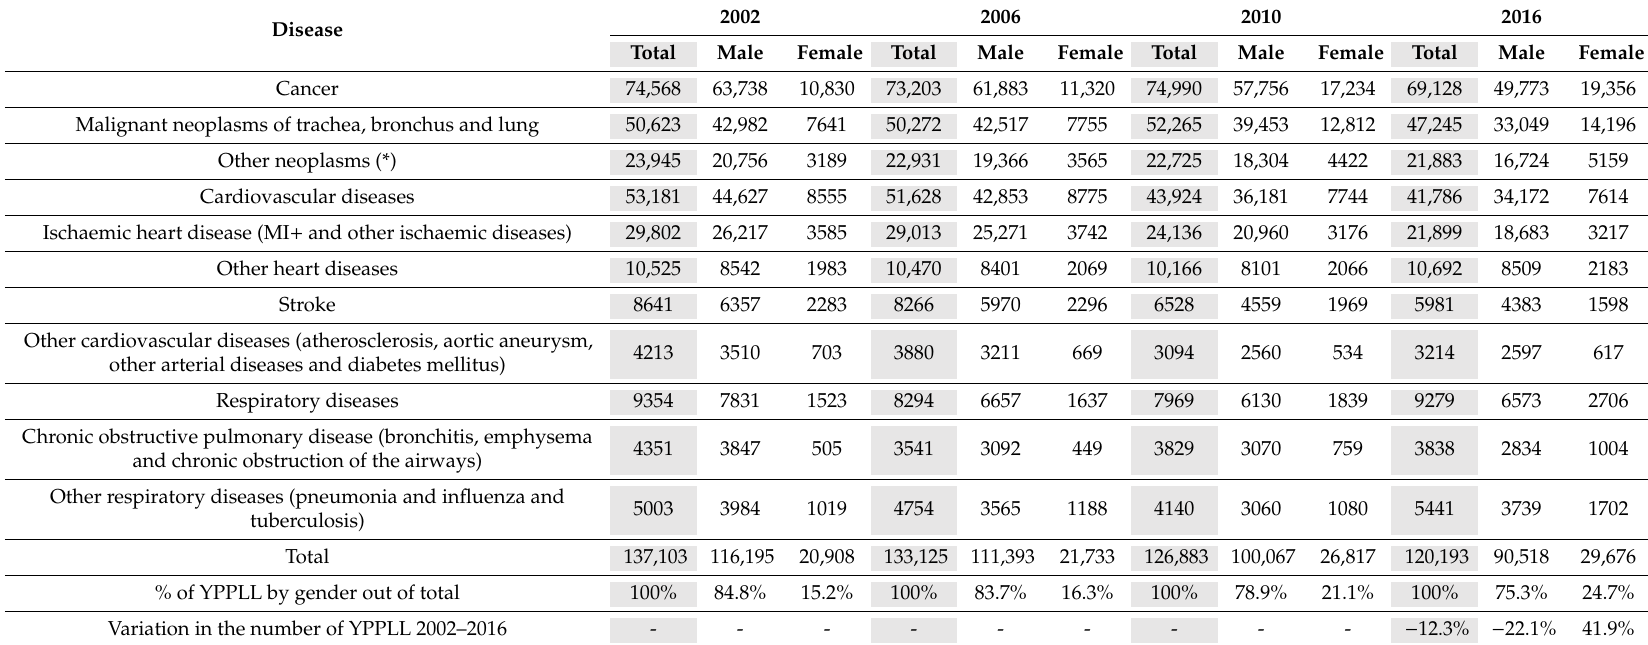
Table 2. Years of potential productive life lost (YPPLL) in working age population (35 to 64 years). Disease